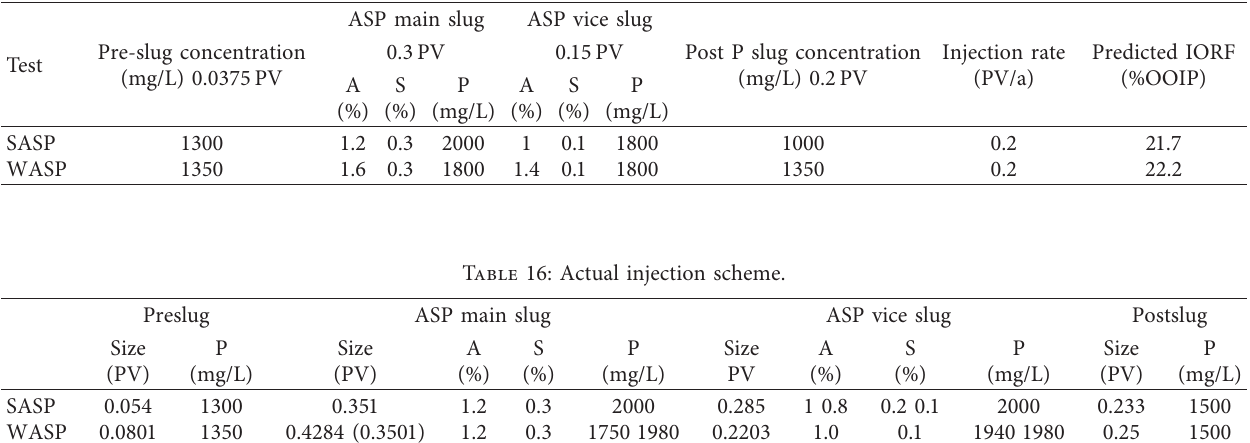
Table 15: Designed ASP scheme.